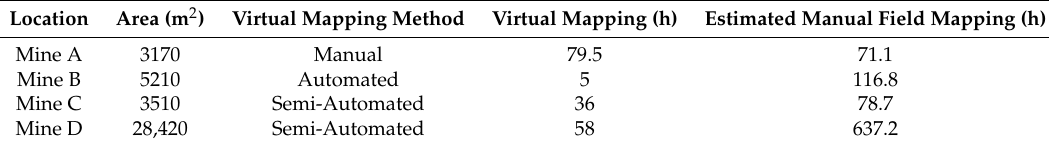
Table 1. Summary of the mapping area, virtual mapping method and mapping time (virtual and field mapping) used for each mine.